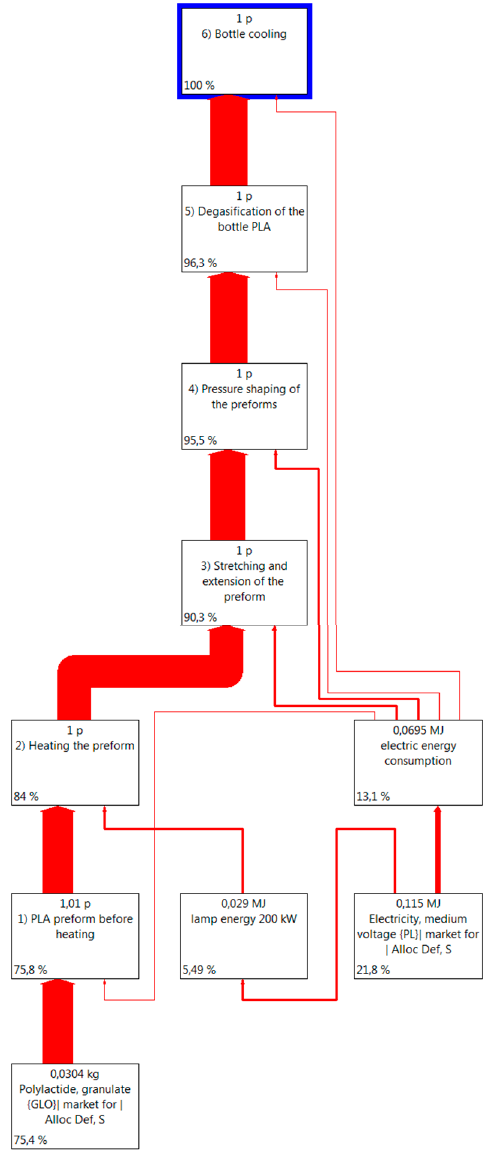
Figure 3. Tree depicts the processes involved in a PLA bottle shaping PLA.